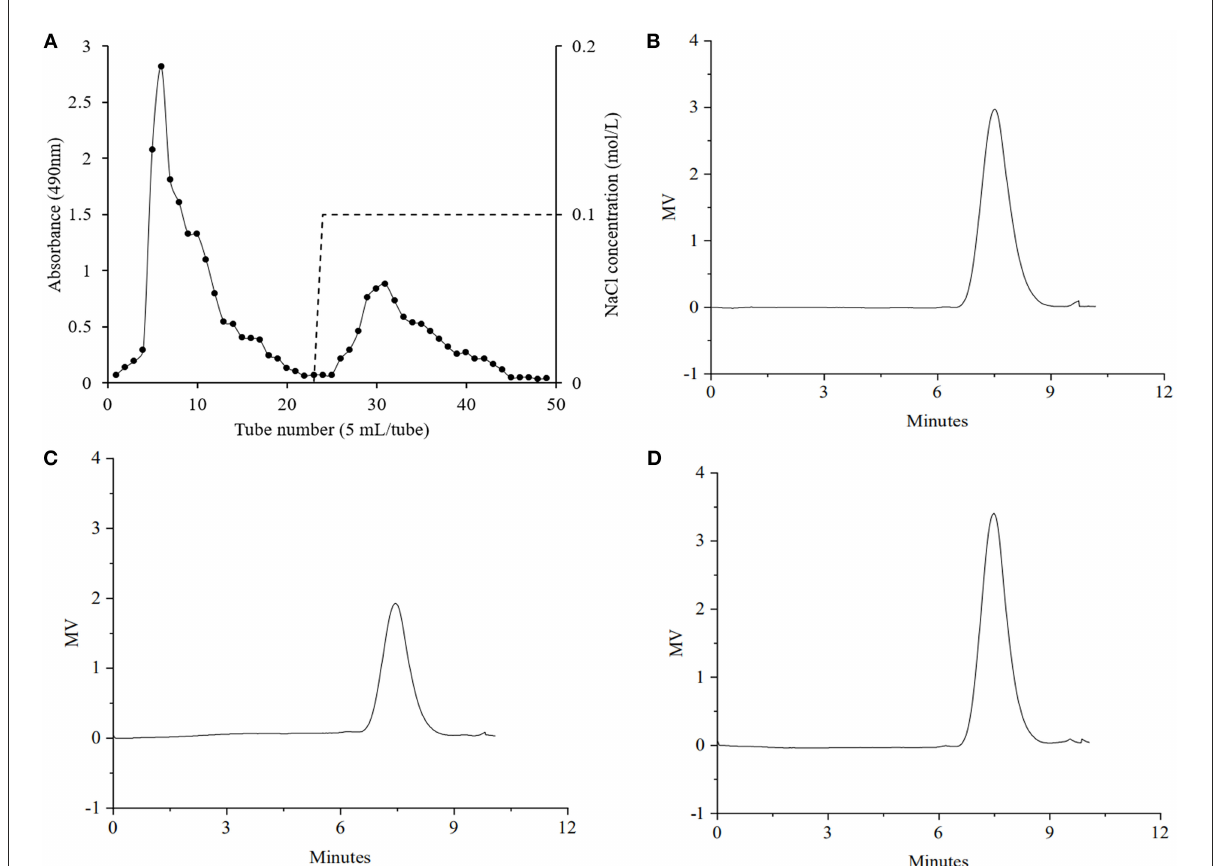
FIGURE1 Elution curve of GRP using DEAE-52 by gradient concentrations of NaCl (A) and gel permeation chromatography chromatograms of GRP (B) , GRP-1 (C) and GRP-2 (D) NaCl concentrations of 0 and 0.1M were marked on the right-side Y axis. GRP, ginsenosides-extracting residue polysaccharides; GRP-1 and GRP-2, fractions separated by 0M and 0.1M NaCl from GRP,